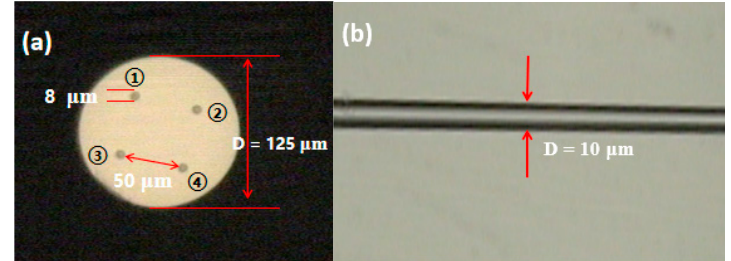
Figure 1. ( a ) Designation of the four cores ① , ② , ③ , ④ in the TFCF interferometer in which c#1 represents the excitation core. ( b ) Microphotograph of the TFCF with D = 10 μ m under a 1000× CCD microscope.